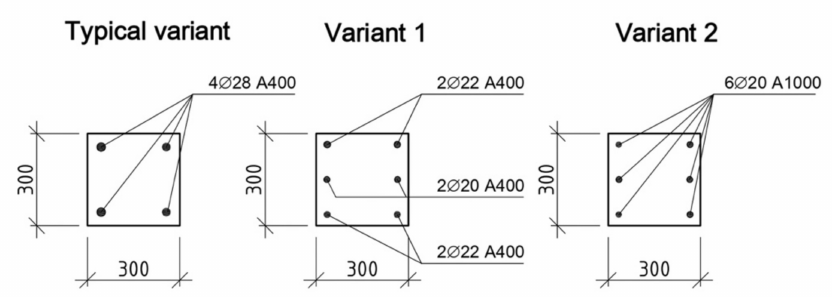
Figure 10. Scheme of a concrete